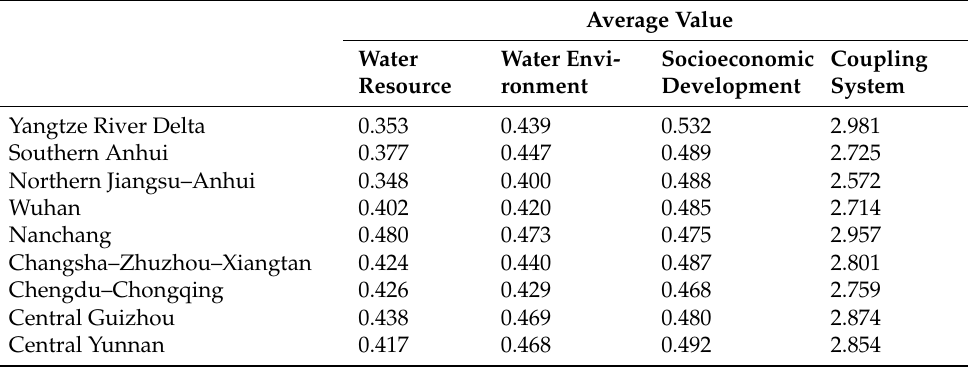
Table 10. The average value of the coupling system in 110 cities.